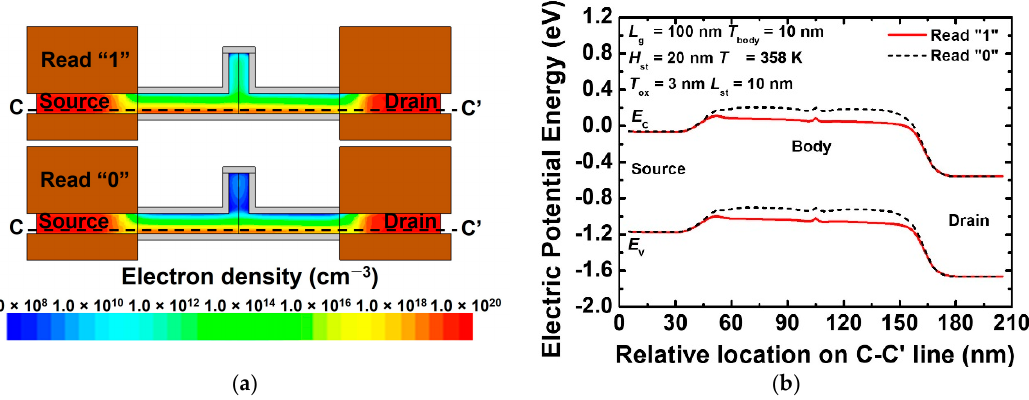
Figure 7. ( a ) Contour map of electron density and ( b ) energy band diagram of proposed 1T-DRAM cell in read states “1” and “0” (energy band is extracted at 3 nm above gate 1 oxide). Figure 8a shows the contour maps of the SRH recombination rate for the proposed 1T-DRAM with different L st in the hold state “1” operation. As shown in Figure 5a, BTBT vertically occurs between gates 1 and 2 in the body region during program operation. Moreover, in Figure 5a, the circular dotted line indicates the region where BTBT is generated, and as L st becomes longer, the area where BTBT occurs becomes smaller.